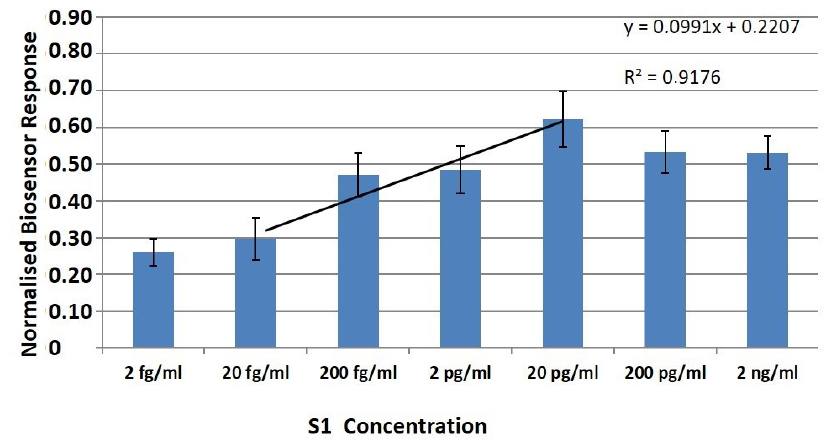
Figure 3. Normalized (vs. control) cell biosensor’s responses in suspension against the SARS- CoV-2 spike S1 protein. SK-N-SH/anti-S1 cells membrane-engineered with 0.5 µ g/mL of human monoclonal antibodies were used as the biorecognition elements. Results (mean ± SE) are presented after three minutes (columns) of sample–cell interaction. Results are expressed as normalized biosensor responses ([control-sample response]/control, n = 24).